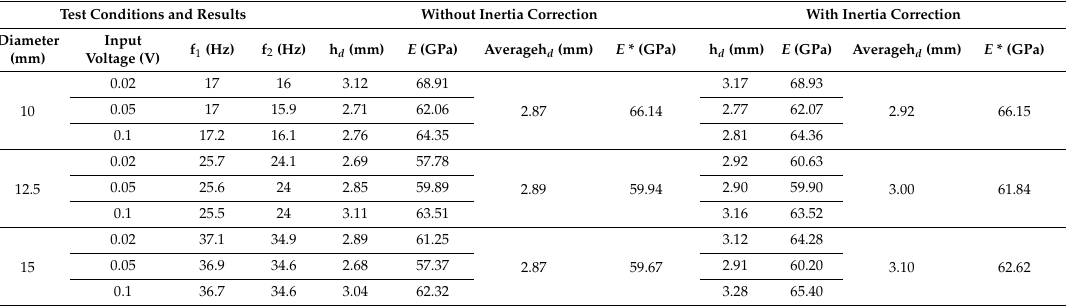
Table 1. Flexural resonant test results of the calibration rods.